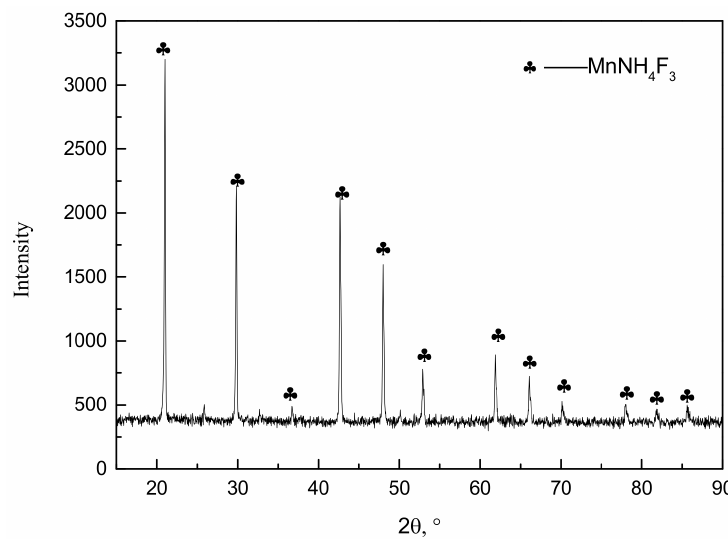
Figure 4. X-ray diffraction (XRD) pattern of the prepared precipitant. The precipitant of MnNH 3 F 3 was added into the vanadium-bearing solution at molar ratio of n (2F)/ n (Ca + Mg) of 1.0, temperature of 65 ◦ C with a stirring speed of 200 rpm, and its purification efficiency is shown by Figure